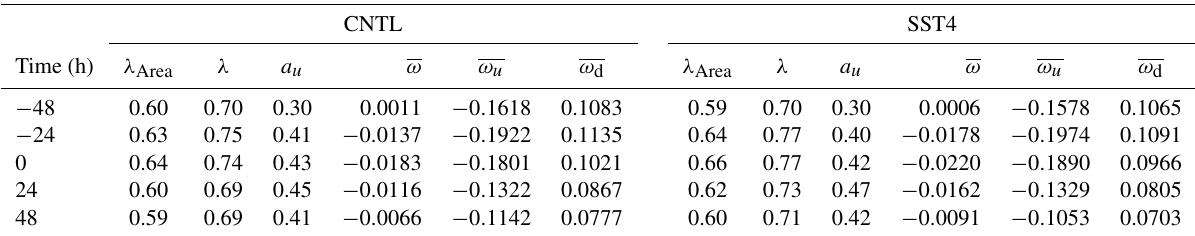
Table 3. Mean values of λ , λ Area (see text for definitions), fractional area of ascent ( a u ), mean vertical motion ( ω ), mean ascent ( ω u ), and mean descent ( ω d ) at 700hPa averaged over the strongest 200 extra-tropical cyclones in CNTL and in SST4 at different offset